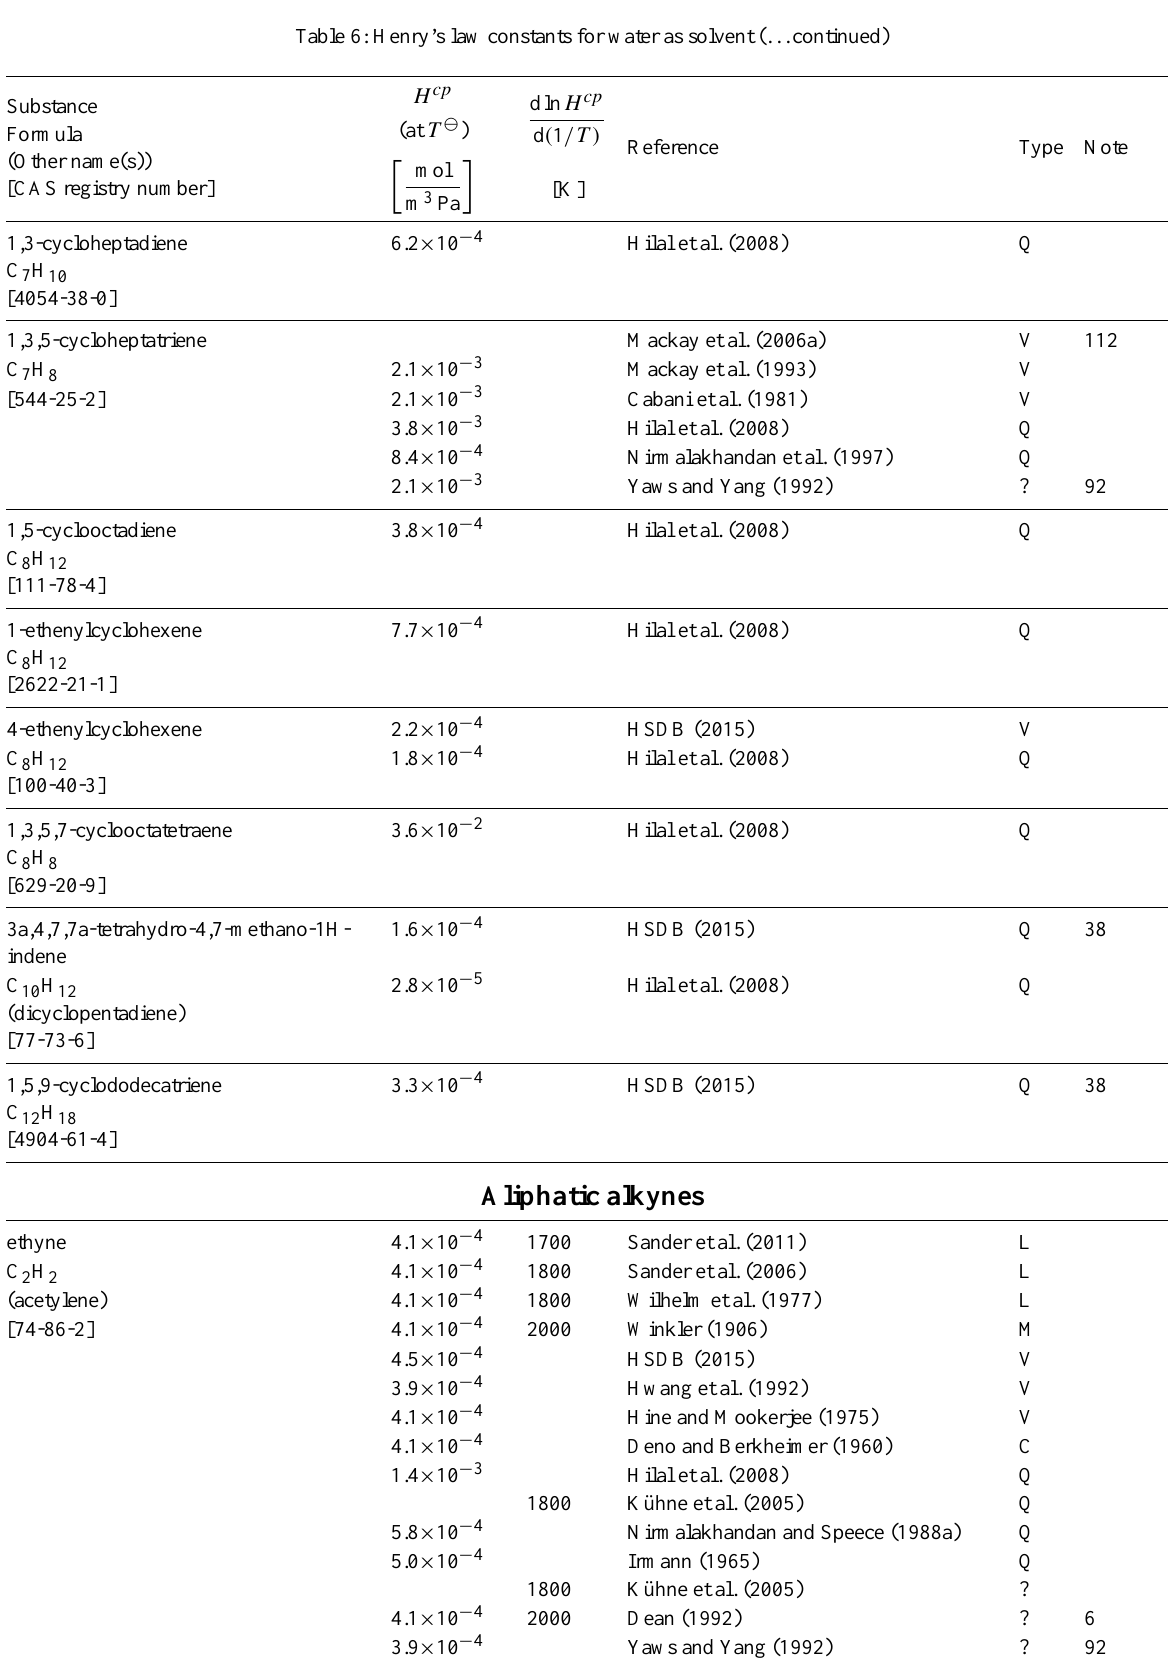
Table 6: Henry’s law constants for water as solvent